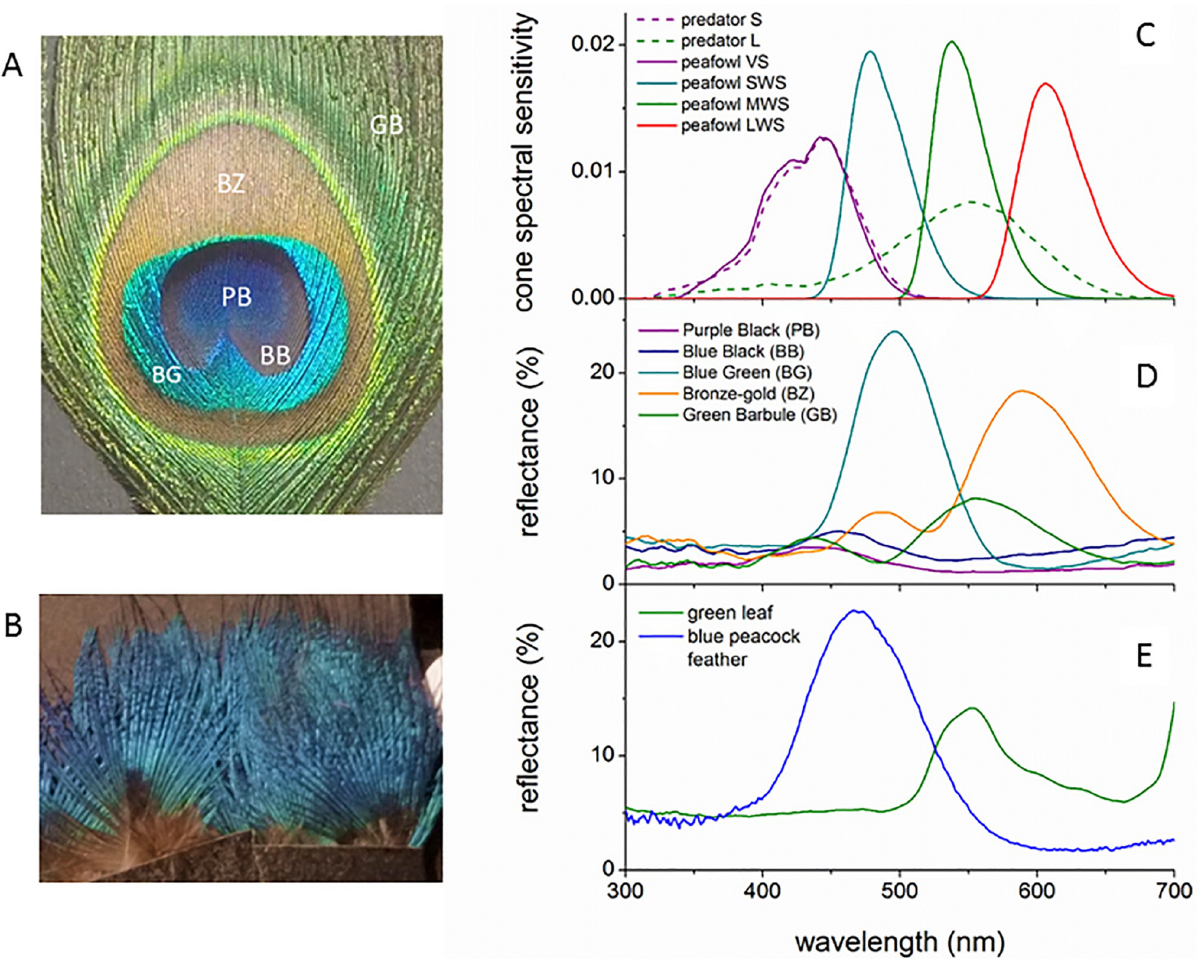
Fig 2. Peafowl feathers, cone sensitivity spectra and reflectance spectra for feathers and green vegetation. (A) An Indian peacock eyespot feather showing the color patch names used in the analysis. (B) Peacock blue breast plumage. (C) Comparison of the cone photoreceptor spectral sensitivities for the Indian peafowl and ferret, which has dichromatic color vision very similar to that of cats and dogs. All spectra are multiplied by the D65 illuminance spectrum used to model sunlight and normalized to unit area. Reflectance spectra of (D) peacock feather eyespots and (E) peacock iridescent blue body plumage and the green saucer magnolia ( Magnolia x soulangeana ) leaf used as a background for the feather sample images.